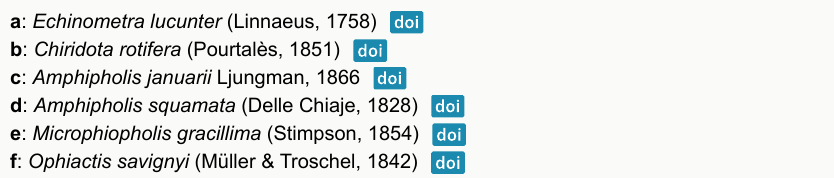
Figure 11. Echinoderms identified on the beaches from Paraíba coast. Scale bars = 5 mm (A and B), 1 mm (C-F). Photos: (A, B and D) modified from Prata et al. (2017); (C,E,F) by Prata,